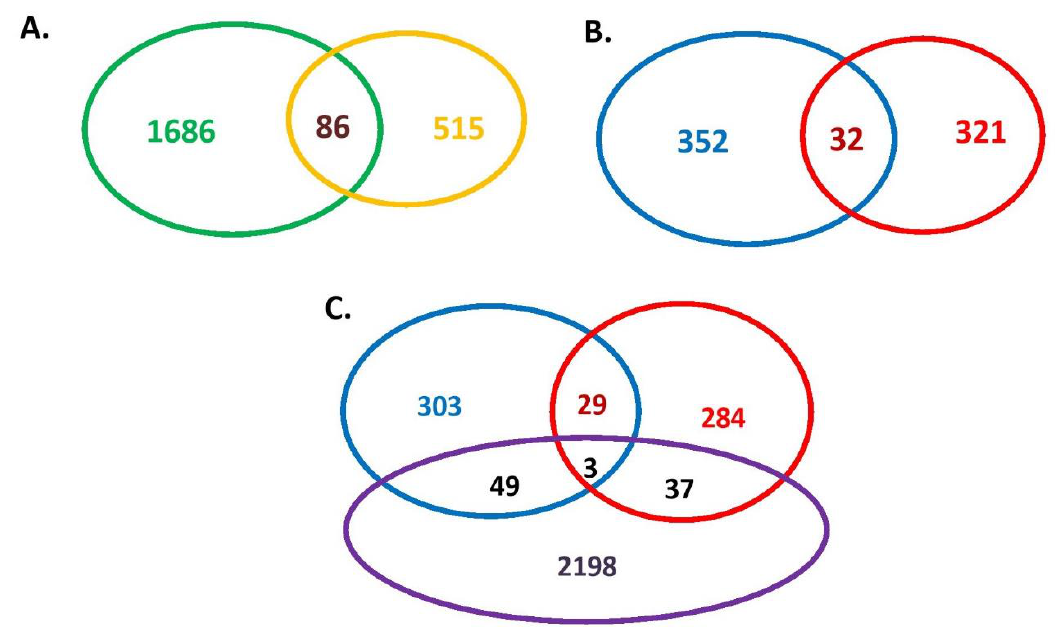
Figure 3. Numbers of genes detected with selection signature analyses and / or RNA sequencing analysis. ( A ) The green circle shows the number of genes detected by XPEHH (1686 + 86 = 1772) and the yellow circle shows the number of genes detected by the Fst method (515 + 86 = 601). The overlapping region shows the number of genes detected by both methods in common (86). The total number of genes checked out by selection signature analyses is 2287 (1772 + 601 − 86 = 2287). ( B ) The blue circle shows the number of di ff erentially expressed known genes (DEKGs) in embryonic liver in a comparison of the Tibet chicken with the lowland chicken (352 + 32 = 384) and the red circle show the DEKG numbers in embryonic heart (321 + 32 = 353). The overlapping region shows the number of DEKGs both in embryonic liver and heart (32). ( C ) The genes of the blue circle ((303 + 49) + (29 + 3) = 352 + 32 = 384) and the red circle ((284 + 37) + (29 + 3) = 321 + 32 = 353) show the same genes as the Diagram. The purple circle shows the number of genes detected by XPEHH and / or Fst methods which is the same value as the gene number in Plot A (49 + 3 + 37 + 2198 = 2287). Of all 705 DEKGs (384 + 353 − 32 = 705), 89 genes including 52 di ff erentially expressed in liver, 40 di ff erentially expressed in heart and 3 overlapping in both of liver and heart, were also screened out by selection signature analyses.